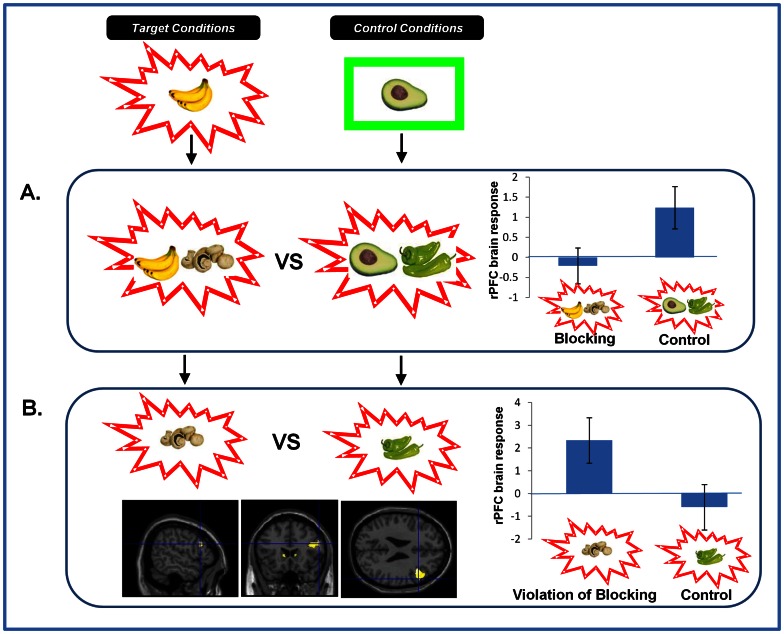
Brain Responses to Blocking and Violation of Blocking.
A. Brain responses to Blocking vs. Control Trials. Right DLPFC responses to blocking trials were significantly attenuated compared with control trials. Parameter estimates extracted from SPM in arbitrary units. Error Bars represent standard error of the mean (SEM). B. Brain Responses to the Violation of Blocking. Violating the blocking at Stage 3 significantly engaged right DLPFC. Parameter estimates extracted from SPM in arbitrary units. Error bars represent SEM.